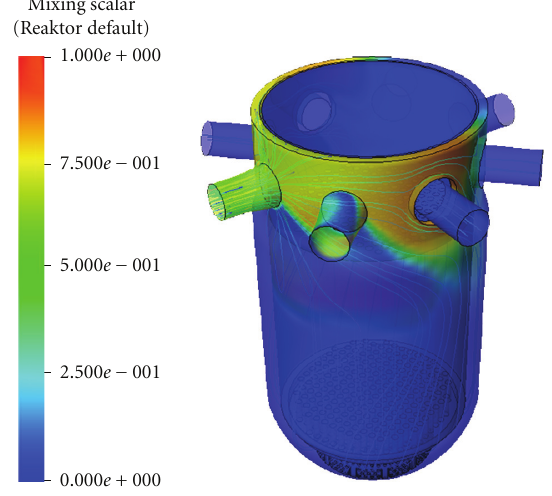
Figure 3: Pump Start-up.